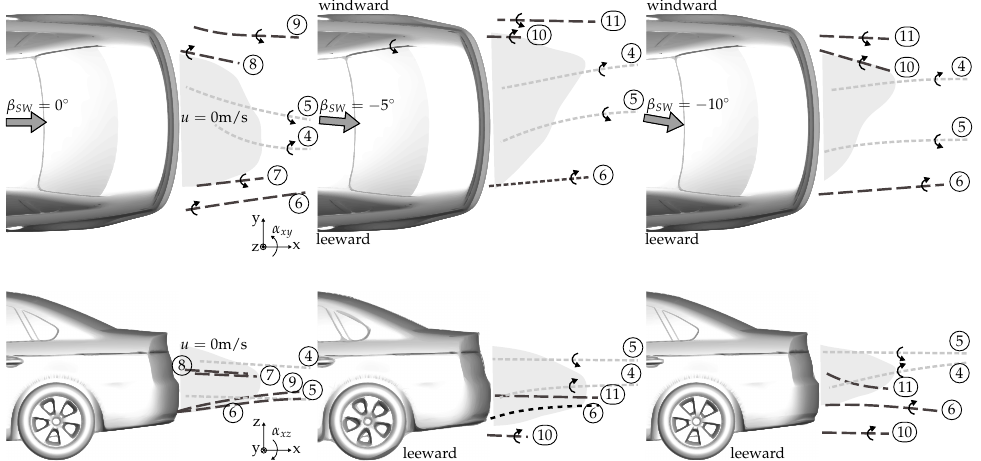
Figure 12. Centerlines of the vortex cores and the size of the recirculation area in the lower part of the model at changing side wind directions. Courses of selected vortical structures and wake length values depending on